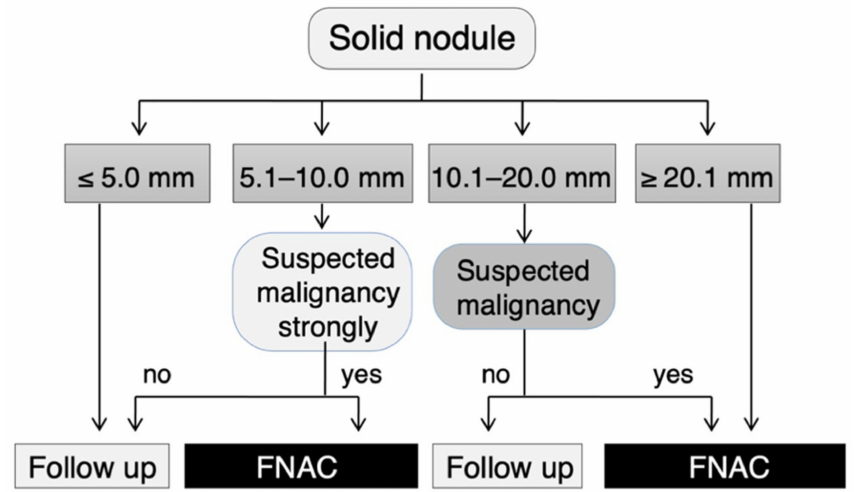
Figure 1. Flow chart for the management of solid thyroid nodules in Japan. This flow chart, showing the management of solid thyroid nodules, was published by the Japan Association of Breast and Thyroid Sonology. For nodules with a spongiform pattern, FNAC is not recommended up to 20.0 mm, with or without malignant findings. Although nodules measuring < 5.1 mm in diameter were not recommended for FNAC, cases with obvious cervical lymph node metastases, family histories of genetic MTC, histories of treatment for high-risk thyroid cancer, or any symptoms indicating cervical extension of thyroid cancer were recommended for FNAC. This figure was created based on Figure 5 of Chapter V in Thyroid Ultrasound–A Guidebook for Diagnosis and Management , 3rd edition [25], with the permission of Nankodo